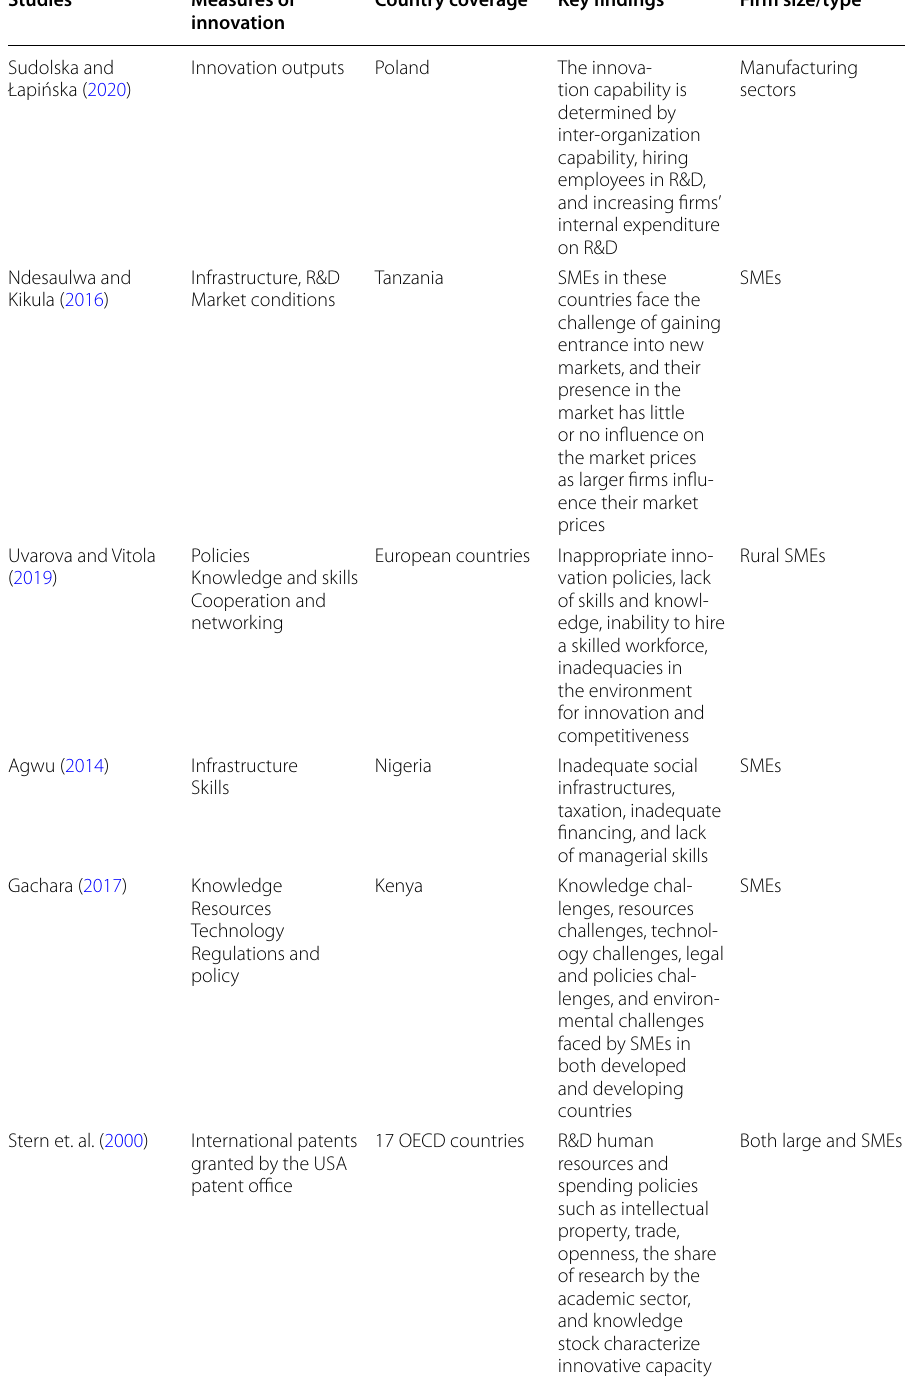
Table 1 Empirical analysis of the determinants of innovation